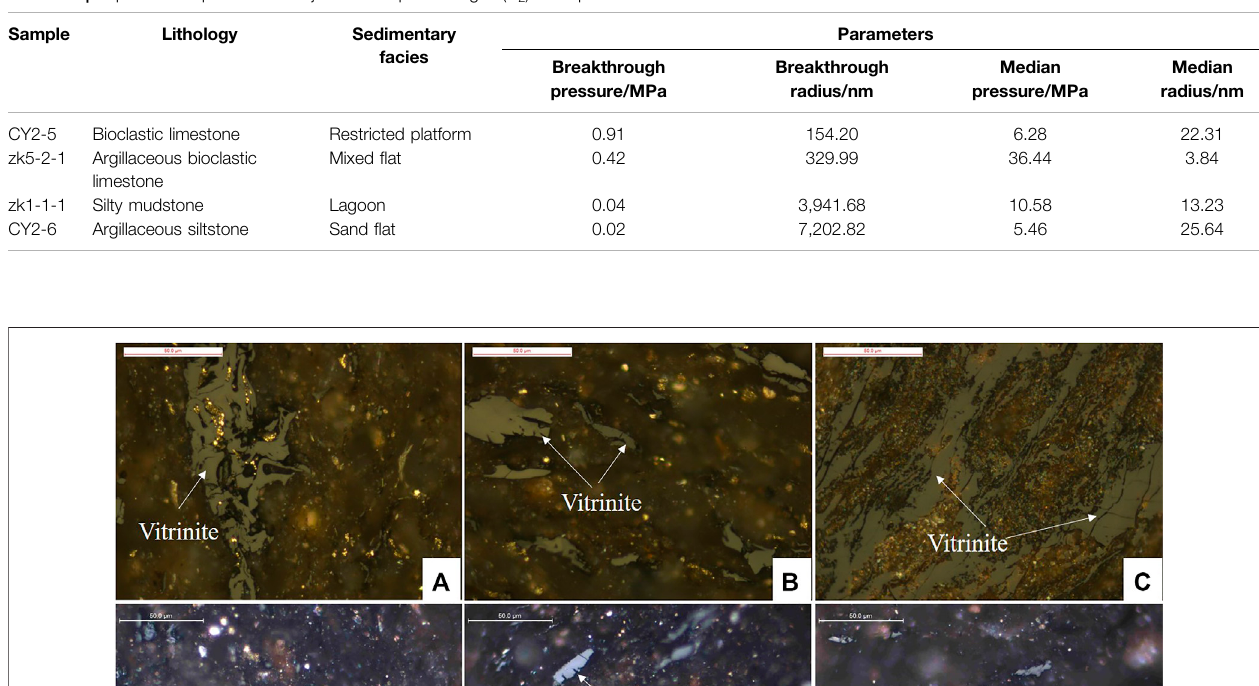
TABLE 2 | Reprehensive parameters of jointed low-pressure gas (N 2 ) adsorption and MICP measurements.